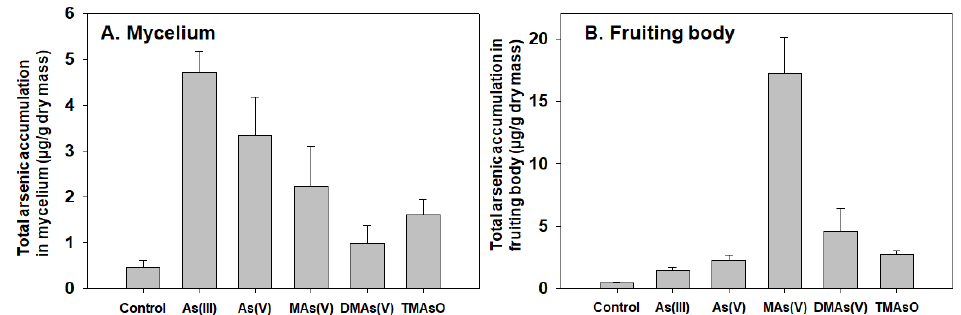
Figure 2. Total arsenic accumulation in A. bisporus mycelium and fruiting body. ( A ) Various arsenic compounds (indicated) were added to the aseptically cultured mycelium at final concentrations of 100 µM (in malt extract medium). After two-hour incubation, the mycelium was collected and filtered, and the total arsenic accumulated in the mycelium was quantified in each sample by ICP-MS. ( B ) To determine arsenic accumulation in fruiting bodies, various indicated arsenic compounds were added to the compost at 5 ppm (final concentration) at the beginning of culture to allow for fruiting. After 3–4 weeks, the fruiting bodies were collected, dried and weighed. Total arsenic in fruiting bodies was quantified by ICP-MS ( N = 4 for mycelium and fruiting body samples).